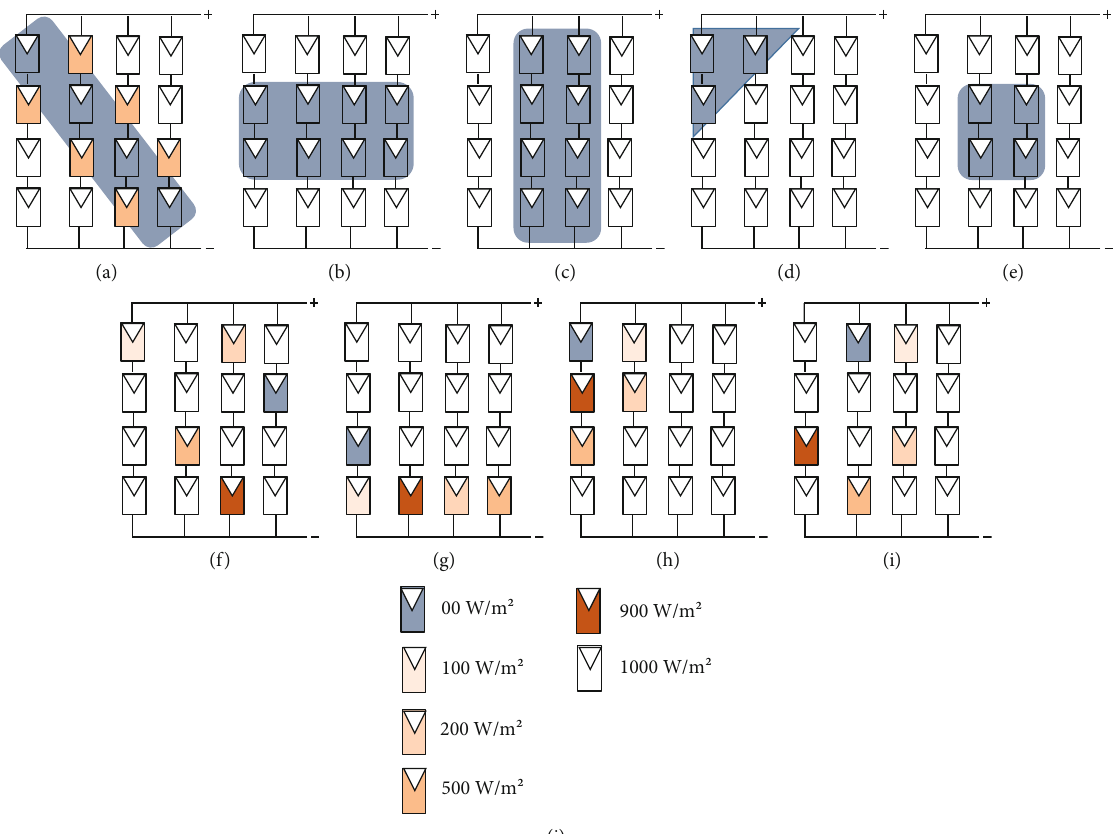
Figure 1: De fi nition of di ff erent shading models under partial shading conditions: (a) DS pattern, (b) FS pattern, (c) VS pattern, (d) CS pattern, (e) CLS pattern, (f) SS-pattern A model, (g) SS-pattern B model, (h) SS-pattern C model, (i) SS-pattern D model, and (j) degree of irradiation levels on PV